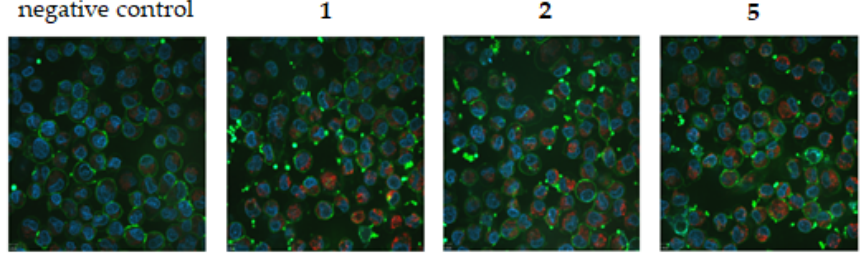
Figure 7. Induction of mROS in A2780cis cells without compound (negative control) and after treatment with 1 , 2 , and 5 (1 µ M) for 24 h and staining with reduced MitoTracker ® Red-H 2 XROS (red), wheat germ lectin (green), and Hoechst 33342 (blue).